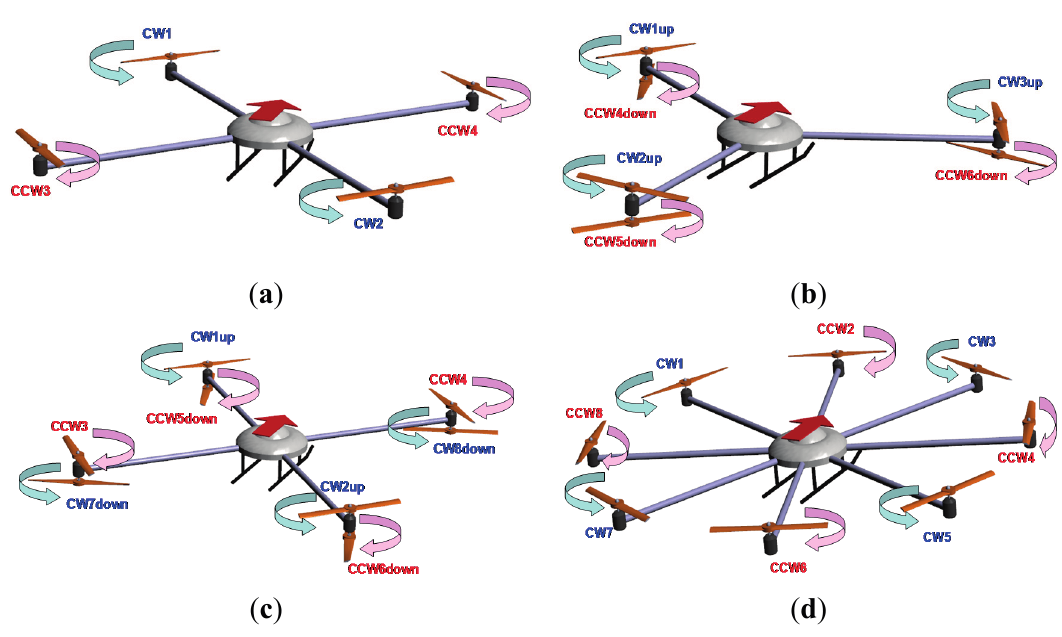
Figure 1. Schematic of movement for typical multirotor: ( a ) quadrotor; ( b ) hexarotor; ( c ) octorotor_type1; and ( d )